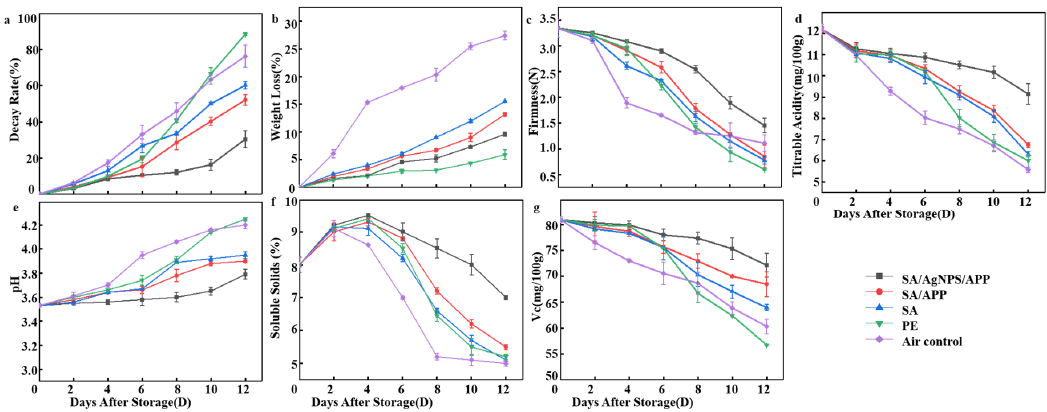
Figure 8. ( a ) Decay rate, ( b ) weight loss, ( c ) firmness, ( d ) titratable acidity, ( e ) pH, ( f ) soluble